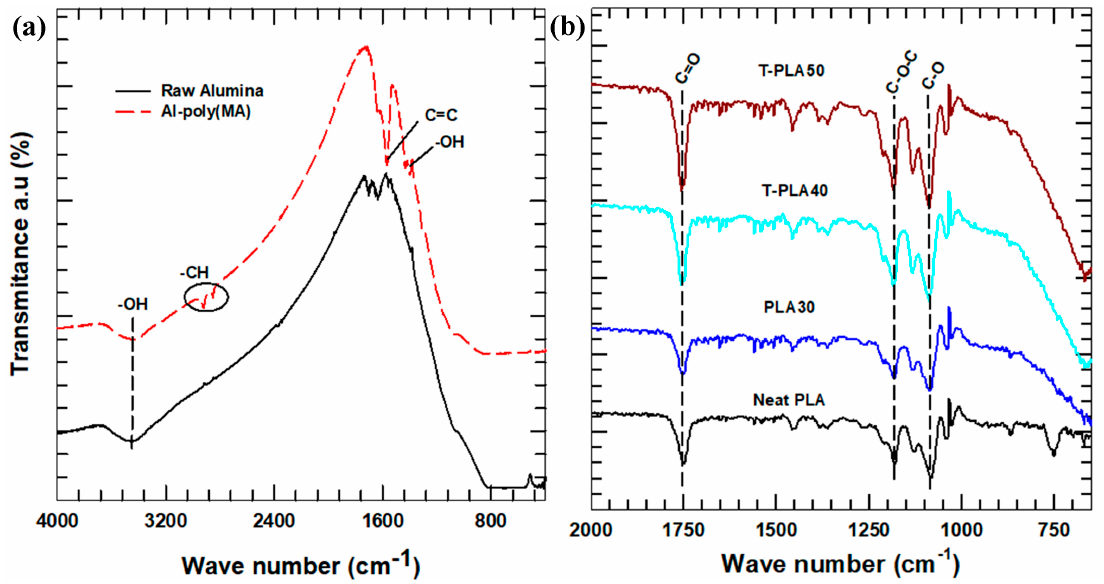
Figure 1. ( a ) FTIR spectra of the raw and treated alumina; ( b ) Attenuated total reflectance Fourier transform infrared spectroscopy (ATR-FTIR) of the polylactic acid (PLA) composites.